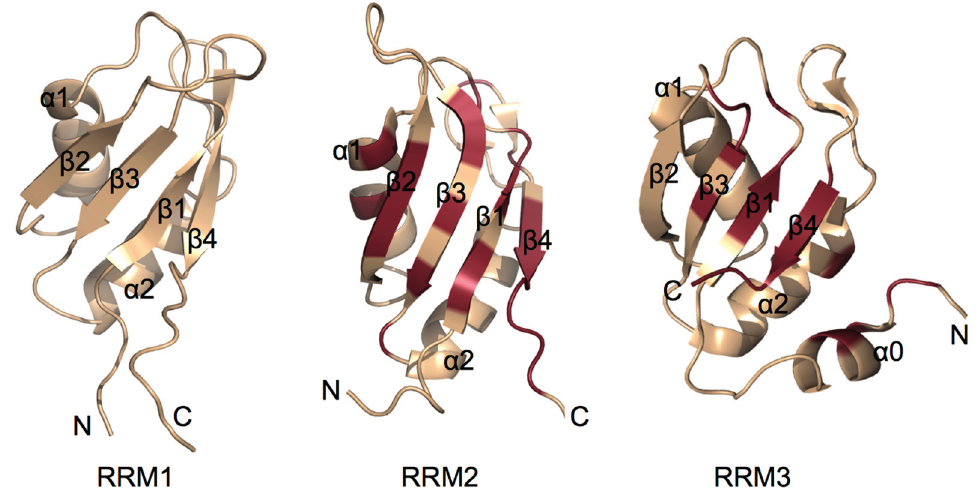
Figure 3. Cartoon representation of TIA protein RNA-recognition motif (RRM)